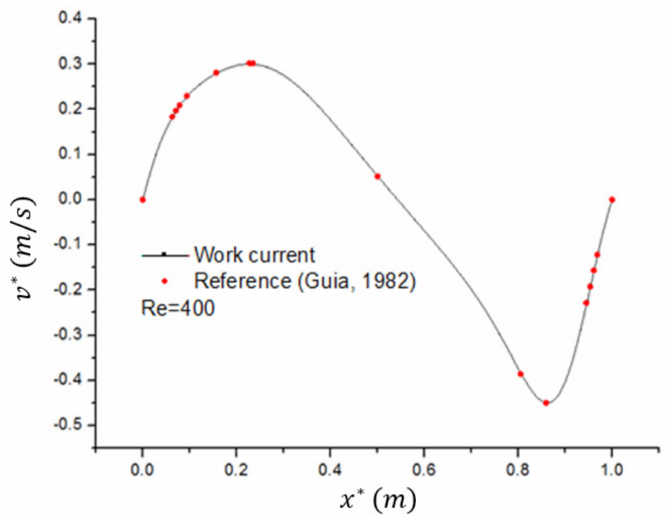
Figure 10. Velocity components within the cavity.